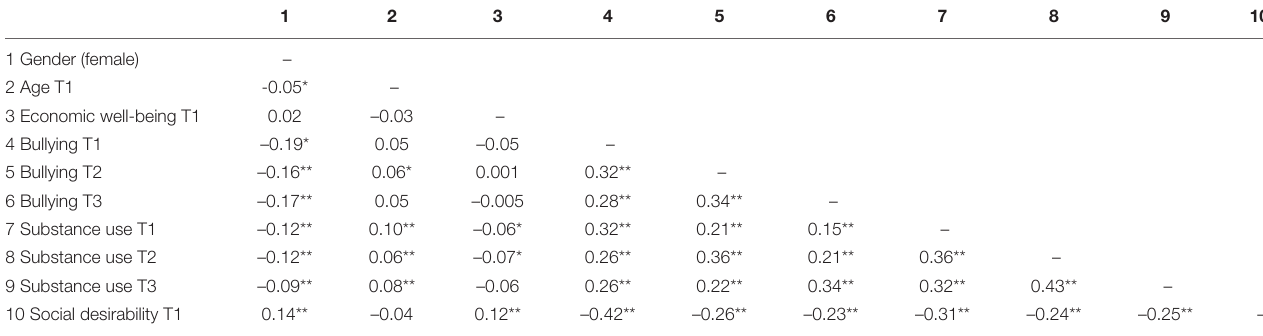
TABLE 3 | Spearman’s bivariate correlations between